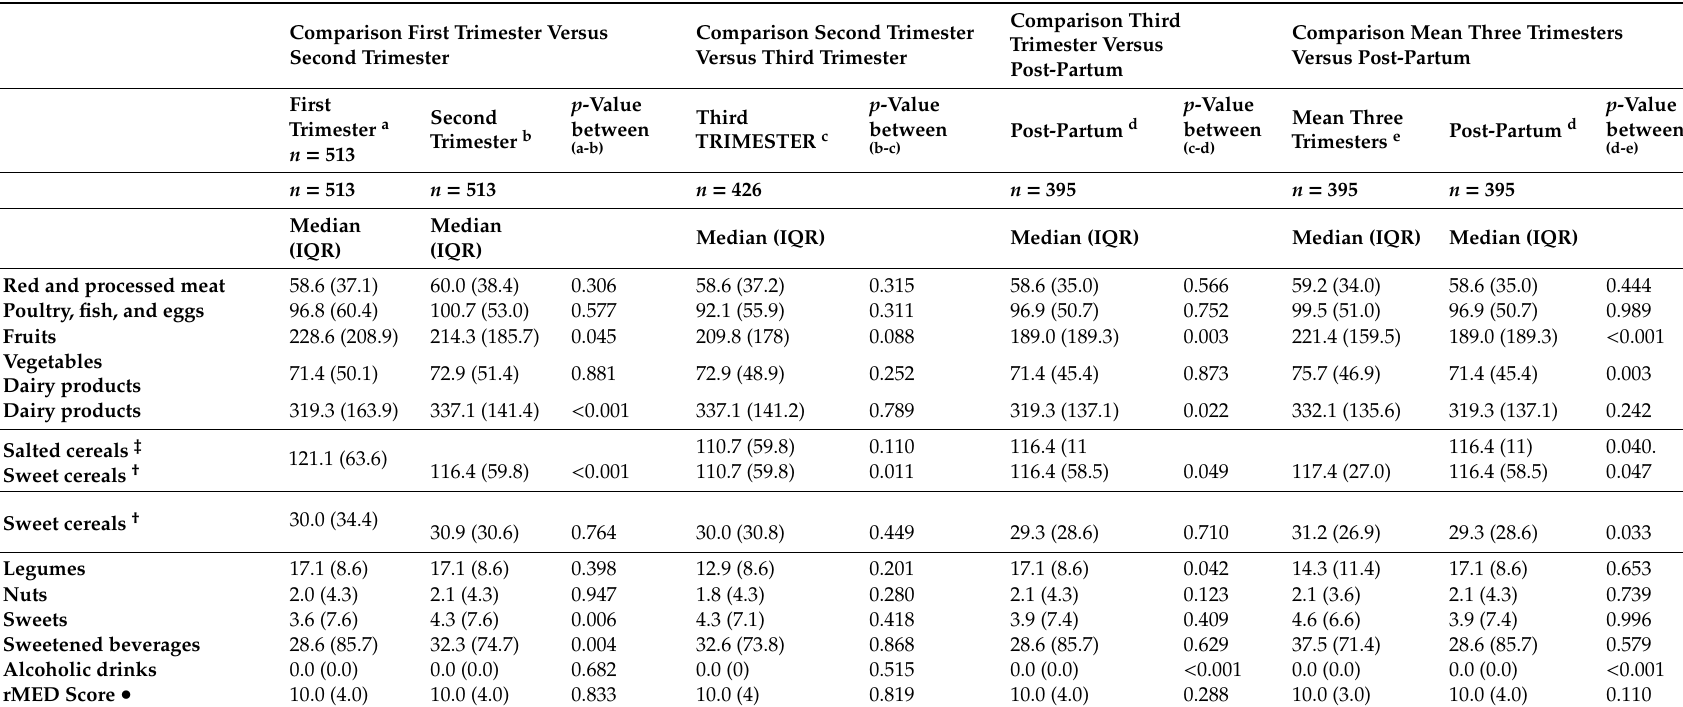
Table 3. Food consumption and adherence to the Mediterranean diet throughout pregnancy and